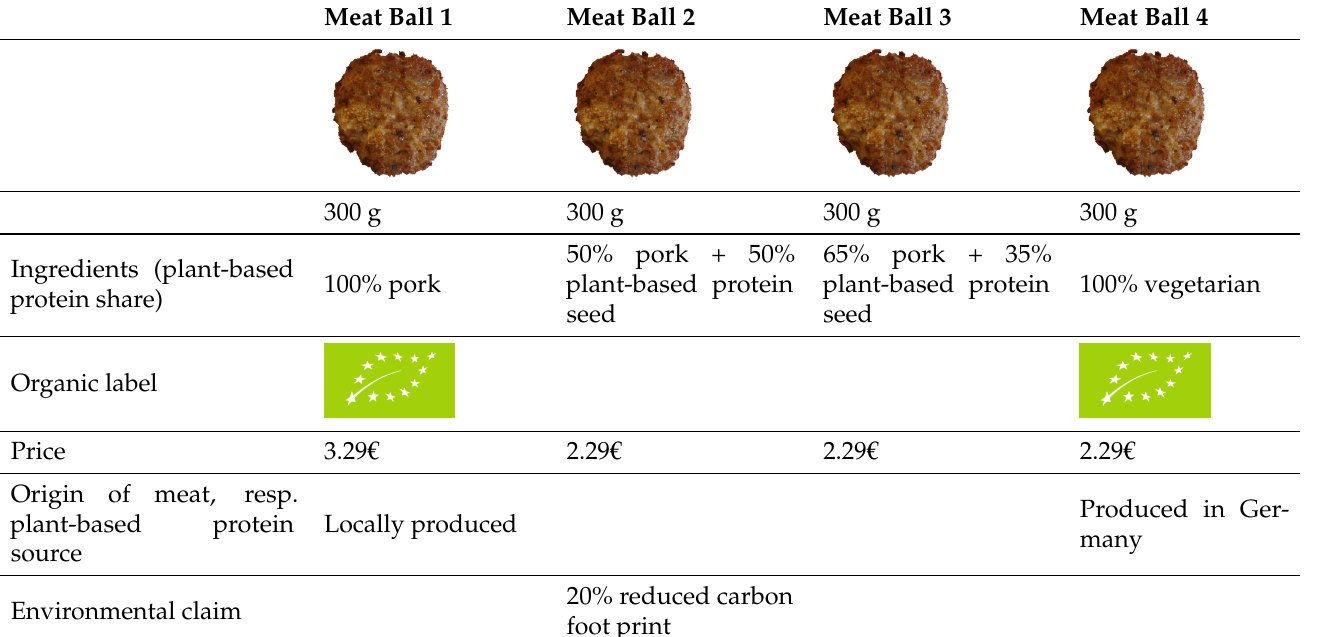
Table 3. Choice set example—meat